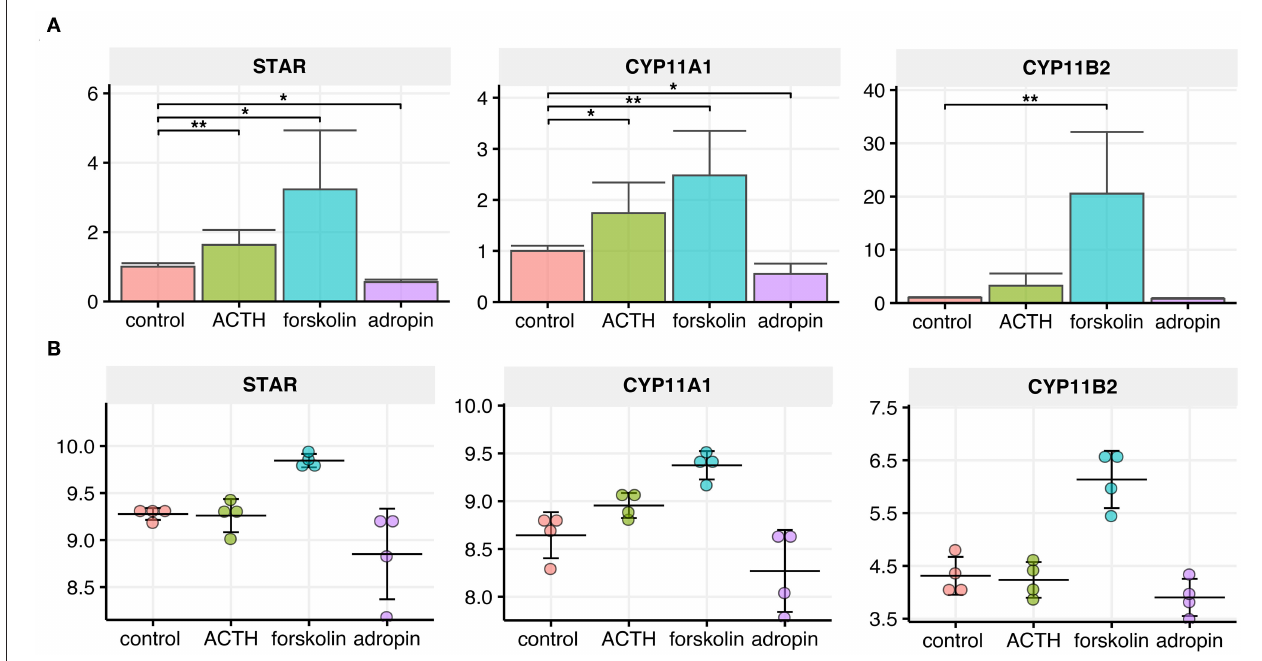
FIGURE 4 | Relative expression levels of CYP11A1 , CYP11B2 and StAR genes in the HAC15 cell line after 24h incubation with ACTH, forskolin, and adropin vs. controls (untreated cells). (A) Real time QPCR study ( N = 4/group). Statistical differences were determined by the Mann–Whitney U non-parametric test compared to controls. * p < 0.05; ** p < 0.01. (B) Normalized expression values extracted from the microarray data set ( N =